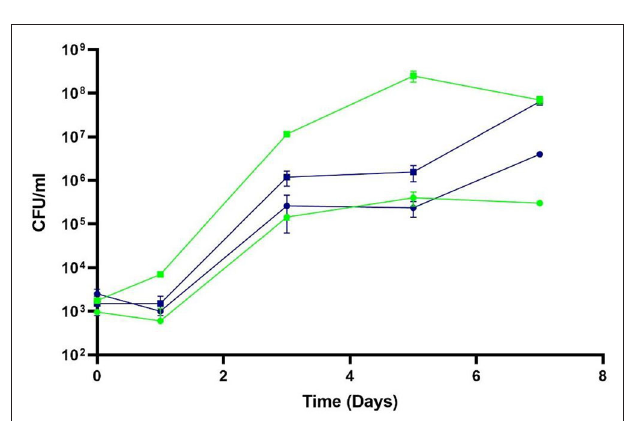
FIGURE 5 | Efficacy of phage P61 against deliberately-inoculated L. monocytogenes strain 3,053 in pasteurized liquid milk at 8 and 12 ◦ C. Samples were incubated at 8 ◦ C (blue symbols) and 12 ◦ C (green symbols) and L. monocytogenes enumerated daily. Squares represent untreated samples; circles represent phage-treated samples. Results are presented as mean values, and error bars represent standard deviations of the